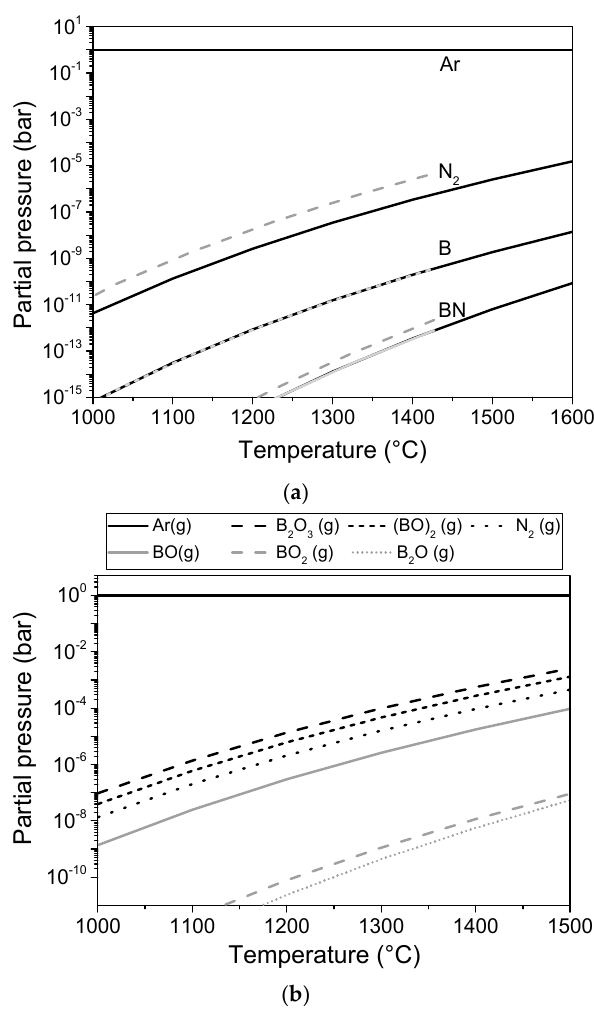
Figure 5. Calculated partial pressures of gas species over h-BN and c-BN ( a ) and h-BN/B 2 O 3 ( b ); (The dotted lines in Figure 5a correspond to c-BN as a solid phase).